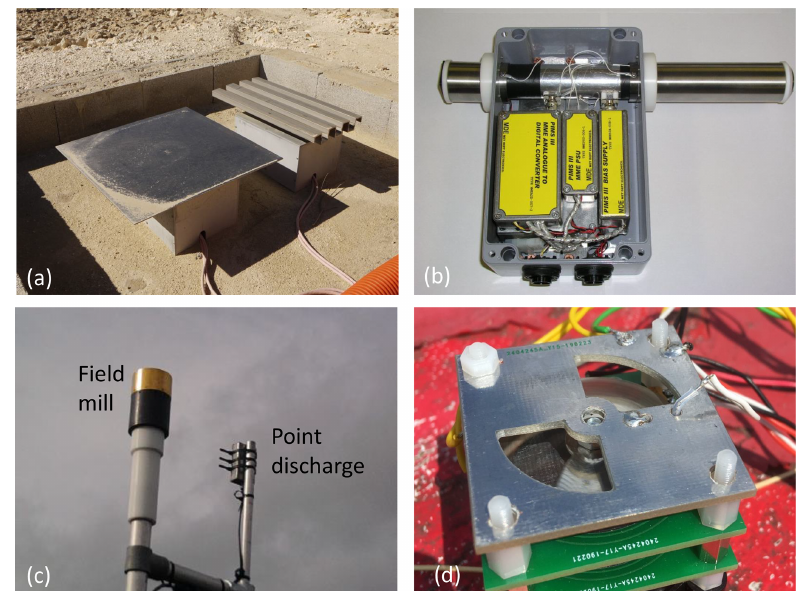
Figure 3. A selection of atmospheric electricity instruments. (a) Vertical current density sensor (GDACCS), using plate and corrugated electrodes, in the Negev desert. (b) Programmable Ion Mobility Spectrometer (PIMS) to determine electrical properties of air. (c) Electric field mill with sensing surfaces uppermost, and upward-pointing point discharge needle (not visible) with logarithmic current amplifier. (d) Miniature field mill with internal calibration